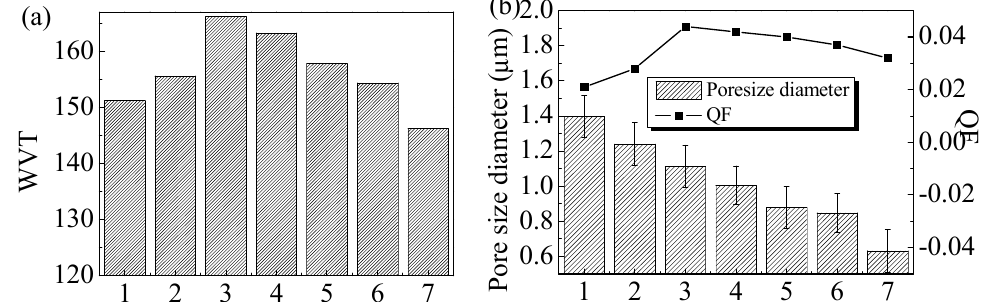
Figure 3. Schematic diagram of the quality factor (QF), pore size diameter, and water–vapour transmission (WVT) of composite membranes: ( a ) the WVT of composite membranes and ( b ) the comprehensive filtration performance and pore size of composite membranes. Columns 1–7 represent Ker.0%/PA6, Ker.30%/PA6 ′ , Ker.30%/PA6, Ag.1%-Ker.30%/PA6, Ag.10%-Ker.30/PA6, Ker.50%/PA6, and Ker.70%/PA6, respectively.